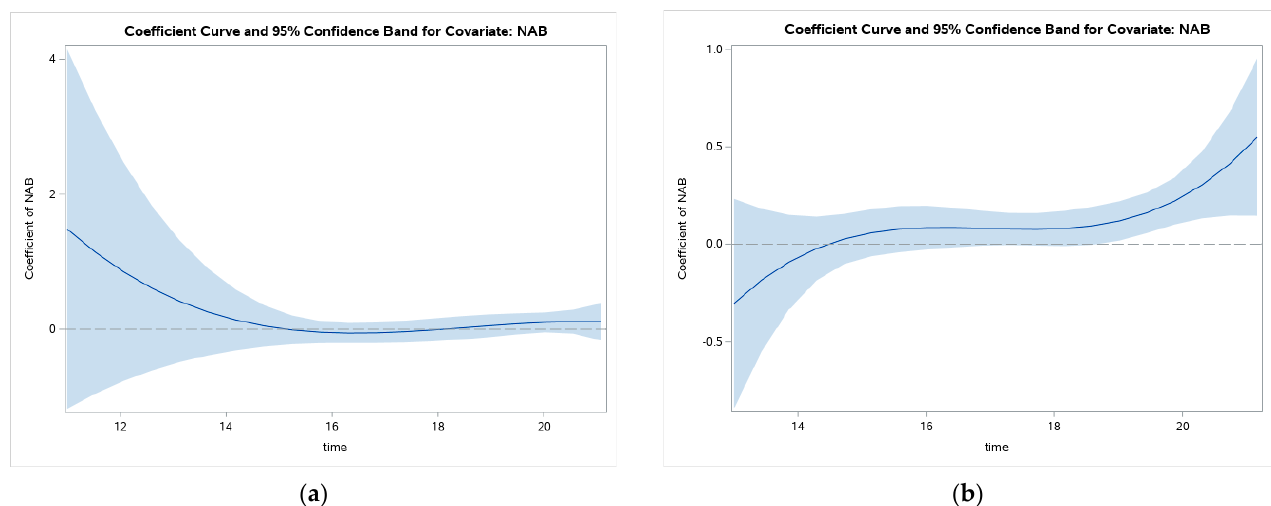
Figure 6. Changes in relations between NAB and GHQ scores through adolescence for Catholics ( a ) and Protestants ( b ).